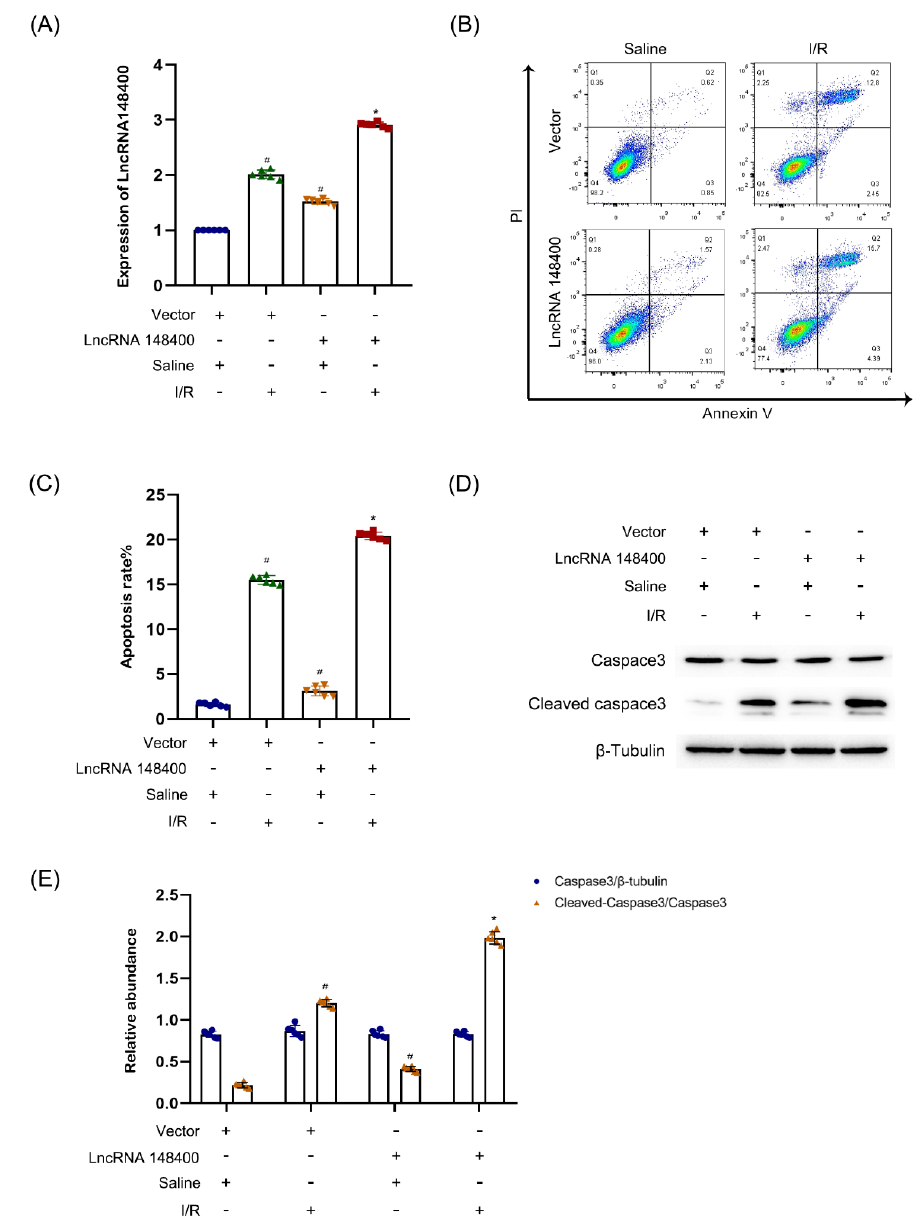
Figure 3. Overexpression of LncRNA148400 enhanced I/R-induced apoptosis and increasing of Cleaved − caspase3 in BUMPT cells . BUMPT cells were transfected with or without lncRNA148400 plasmid, and then treated with or without I (2 h)/R(2 h) injury. ( A ) RT − qPCR analysis of the expression of LncRNA 148400. ( B ) FCM analysis of apoptosis in BUMPT cells. ( C ) Representative apoptosis rate (%). ( D ) The immunoblot analysis of caspase 3 and cleaved − caspase 3. ( E ) The gray analysis between them. Data are expressed as mean ± SD ( n = 6). # p < 0.05 vs. saline with scramble group; * p < 0.05 vs. I/R with scramble group.